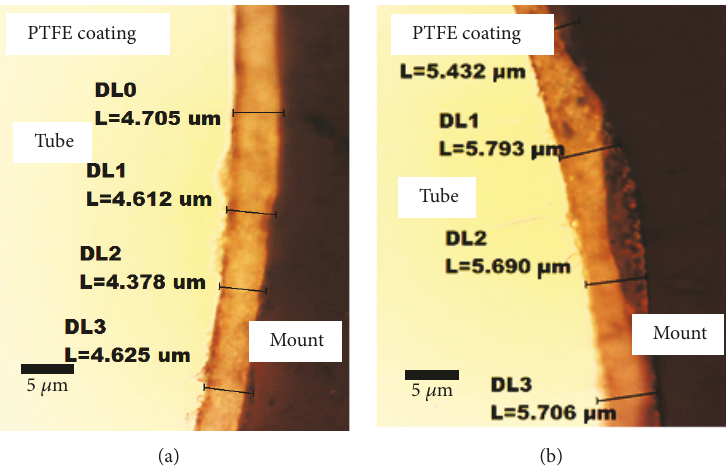
Figure 5: Optical micrographs of the cross-sectional area of the sample at different viscosities: (a) 900 mPa ⋅ s and (b) 1100mPa ⋅ s (withdrawal rate of 20mm/s, spin speed of 500 rpm, and immersion time of 10 s).